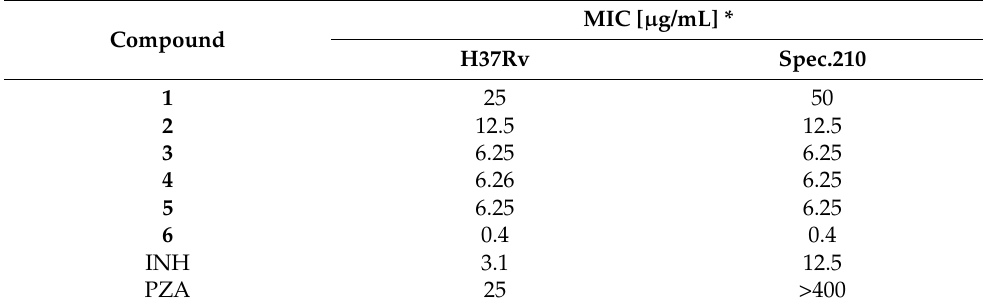
Table 1. Tuberculostatic activity of 2-amidinothiosemicarbazone pyridine derivatives 1 – 6 [14] .